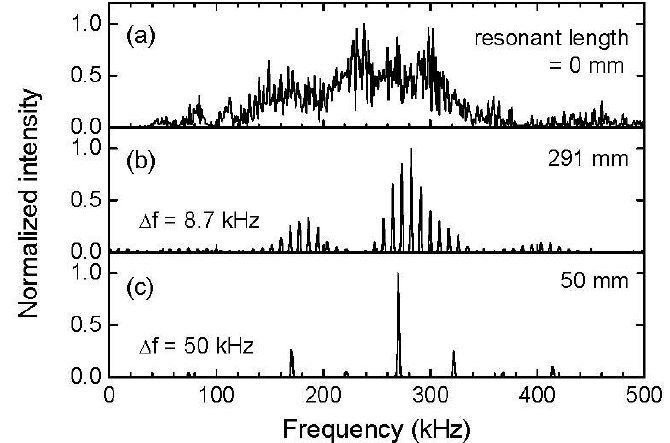
Figure 5. Frequency characteristics of the FBG sensor responses depicted in Figure